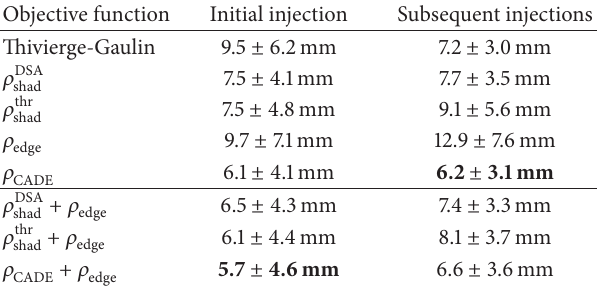
Table 3: Translation errors for temporal filtered